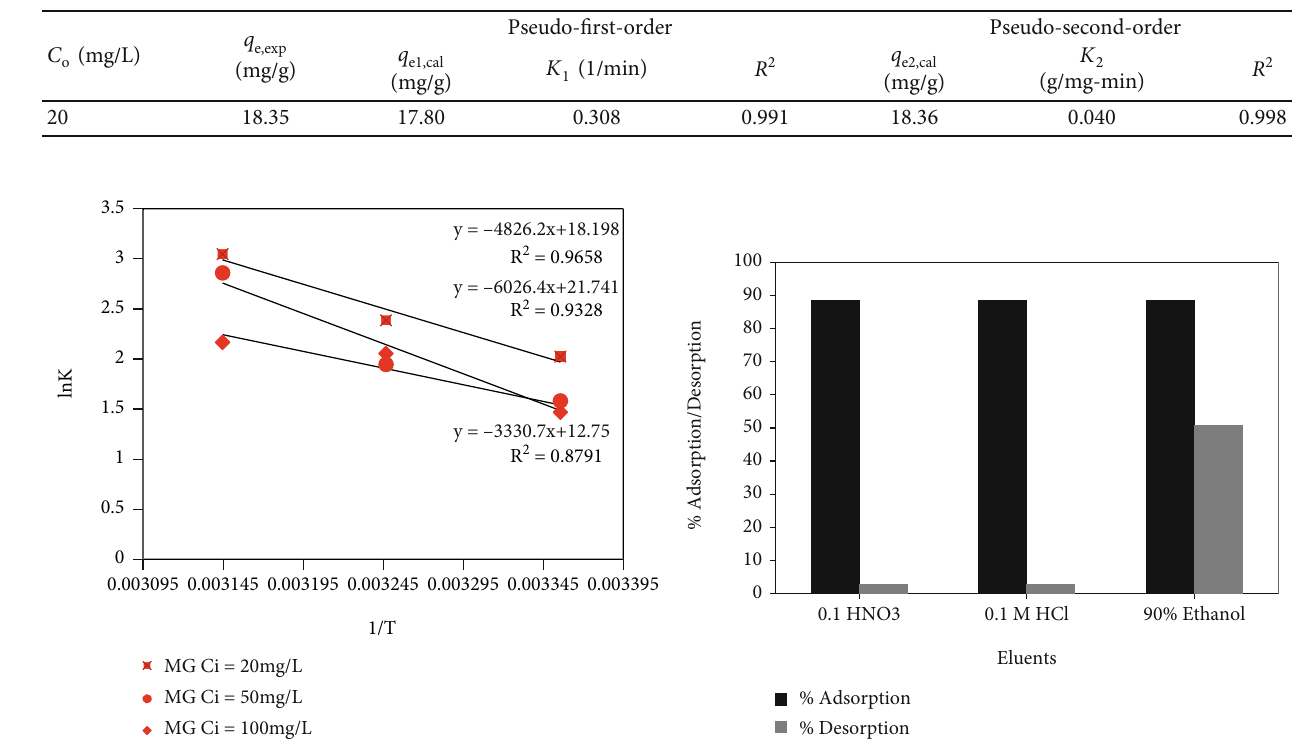
O @AJPL (conditions: MG — 20mg/L, time — 120min, 3 4